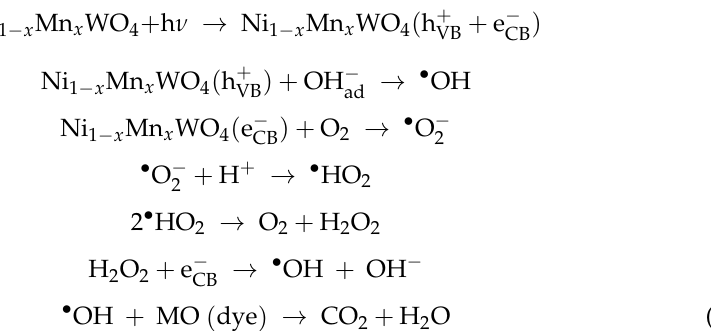
Figure 9. UV-Vis spectra for the scavenger test for the degradation of MO by Ni 1 − x Mn x WO 4 NC. Based on the trapping experiments, the plausible general mechanism of MO degrada- tion is given by Equations (4–10) [1,4,8]: